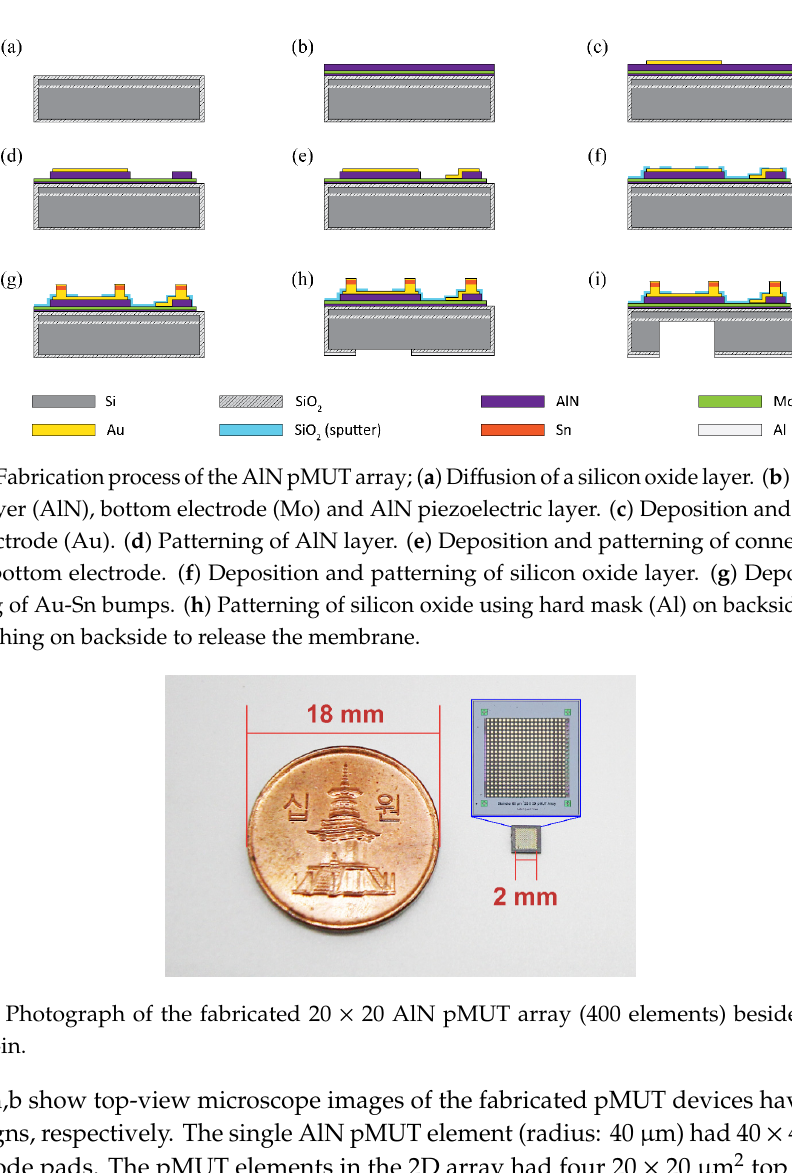
Figure 3. Photograph of the fabricated 20 × 20 AlN pMUT array (400 elements) beside a 10-won Korean coin.